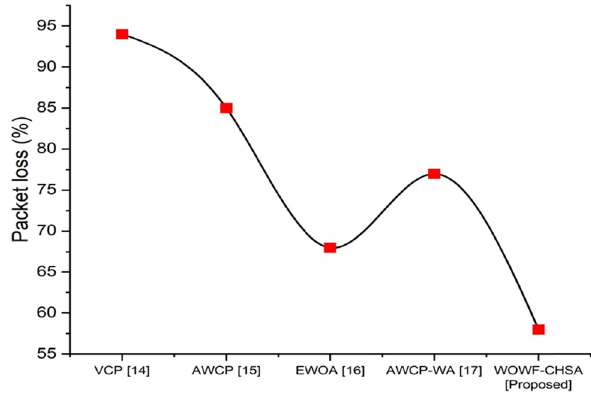
Figure 7: Results of proposed and existing methodologies for packet loss.